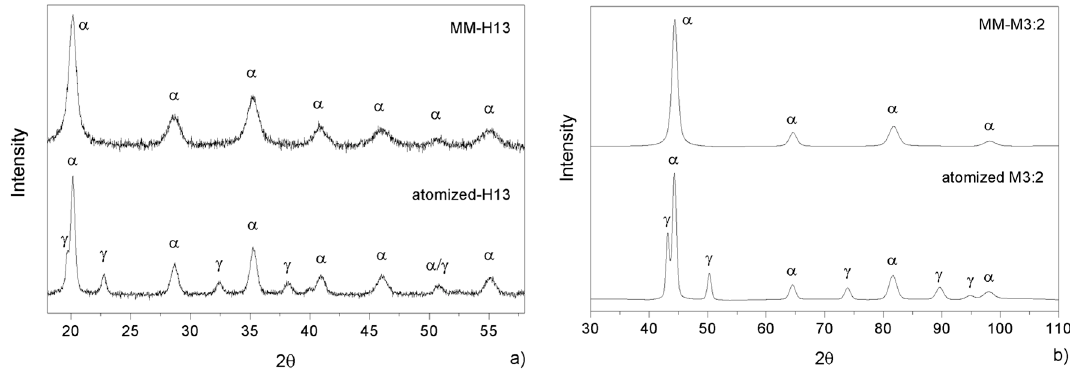
Figure 4. X-ray diffraction patterns for as-atomized and MM ( a ) AISI H13 and ( b ) AISI M3:2 powders.